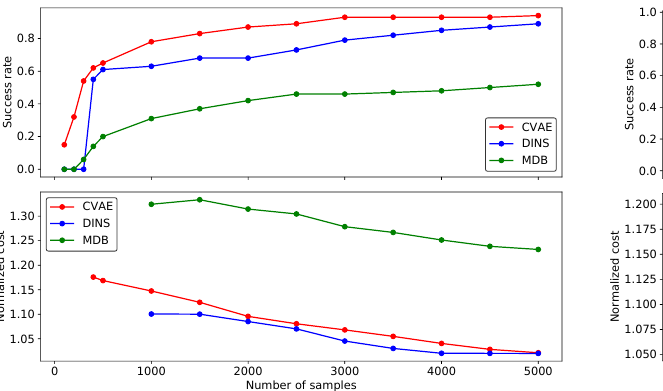
Figure 8: Comparison of the convergence rate when the starting point is within human experience in the Trondheim harbour.